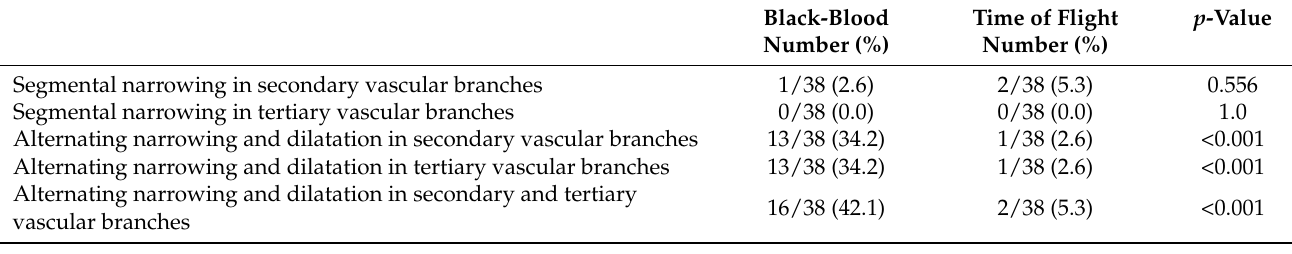
Table 4. Results of the cerebral MRI angiography in the investigation group.